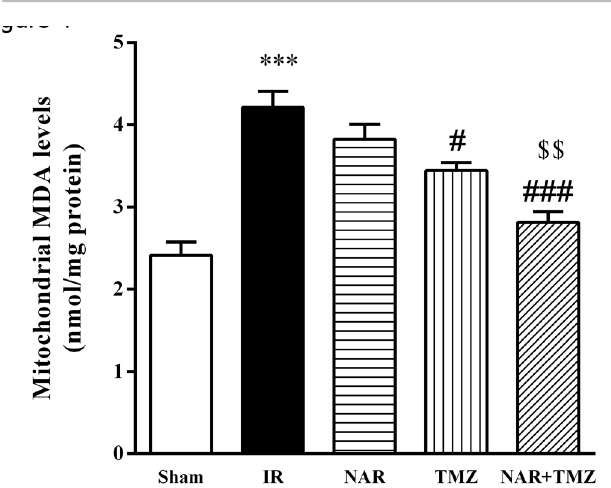
FIGURE 4 - Effect of Naringin (NAR) and Trimetazidine (TMZ) or their combination pretreatment on mitochondrial ROS following renal IR injury (mean ± SEM n=8). Sham (sham operated group), IR (Ischemia-reperfusion + normal saline), NAR (Ischemia-reperfusion + 100 mg/kg, intraperitoneally, for one week), TMZ (Ischemia + 5 mg/kg TMZ, intravenously, before reperfusion) and their combination (NAR + TMZ). One- way ANOVA followed by Tukey’s post hoc test. ***p< 0.001 vs. sham group; ## p< 0.01; ###p< 0.001 vs. IR group; $ p< 0.05 vs. NAR group.